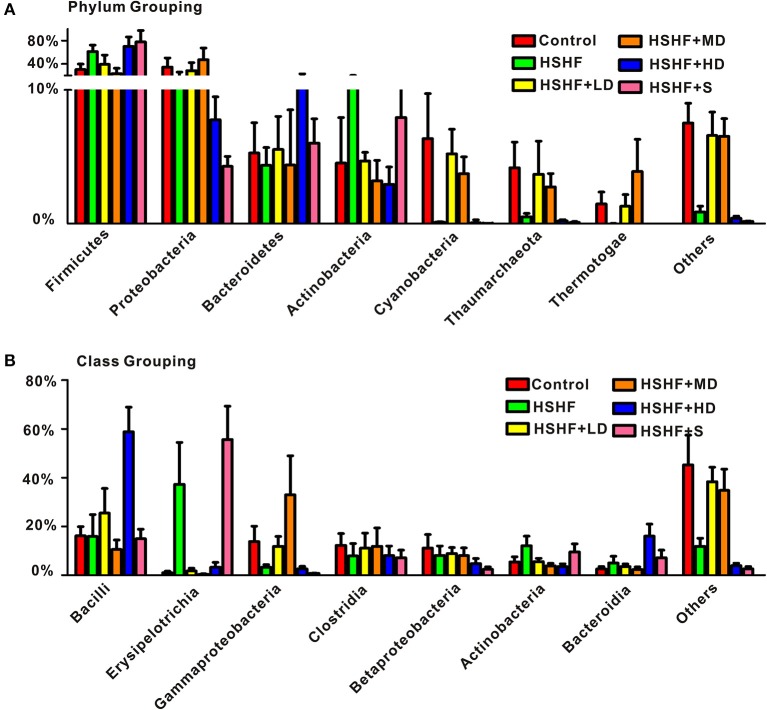
RDP classifications of the average sequences reads. (A) At the phylum level and (B) at the class level. Data are presented as the means ± S.D.